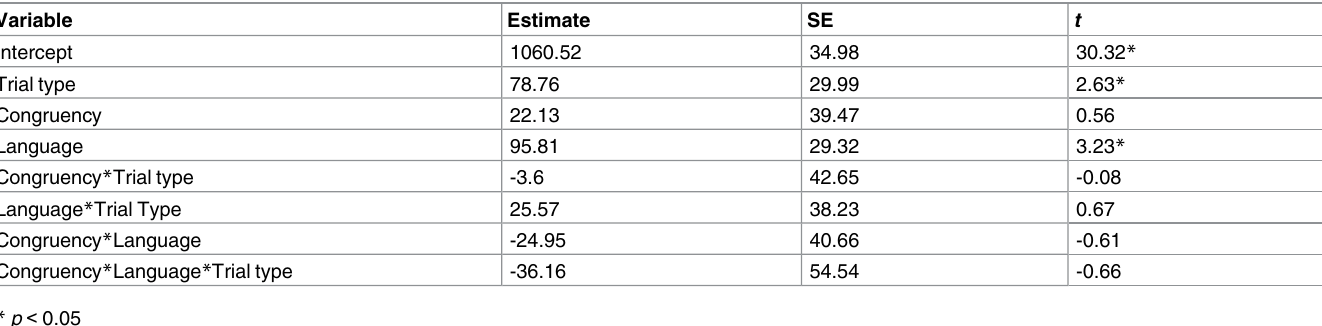
Table 3. Results on Naming latency in the cued block (Experiment